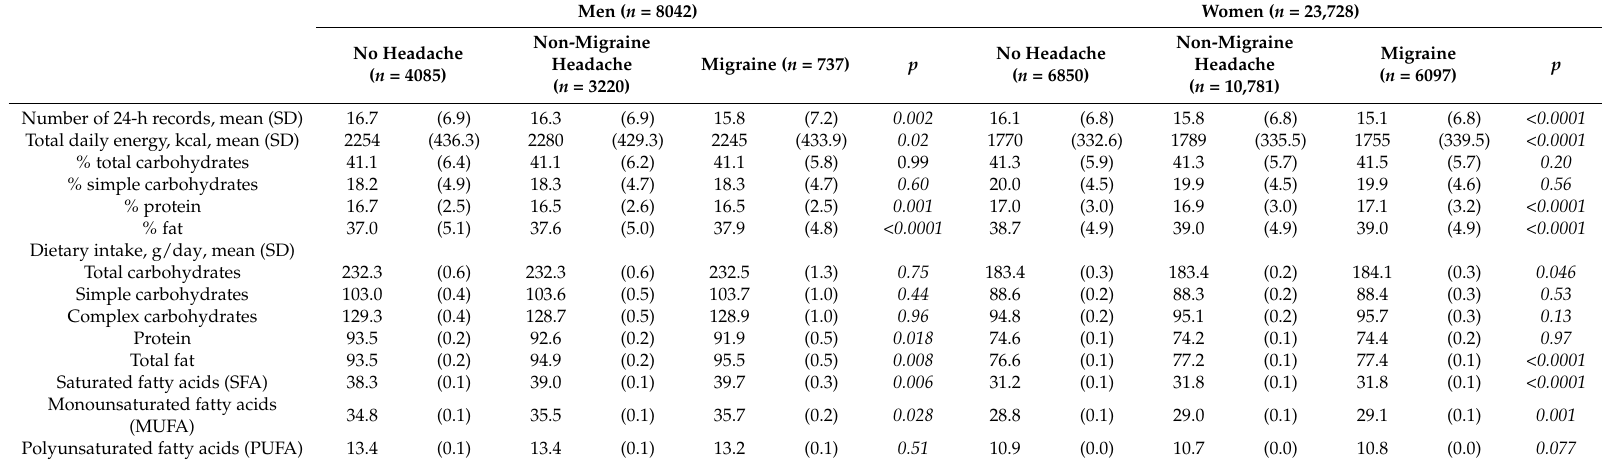
Table 2. Mean macronutrient intake by gender and headache status (NutriNet-Sant é , n =